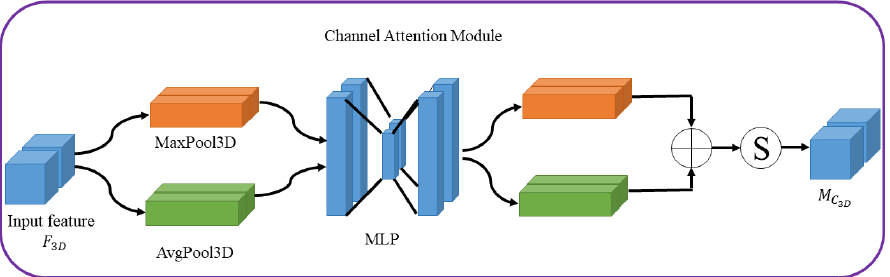
Figure 4. Diagram of the channel attention